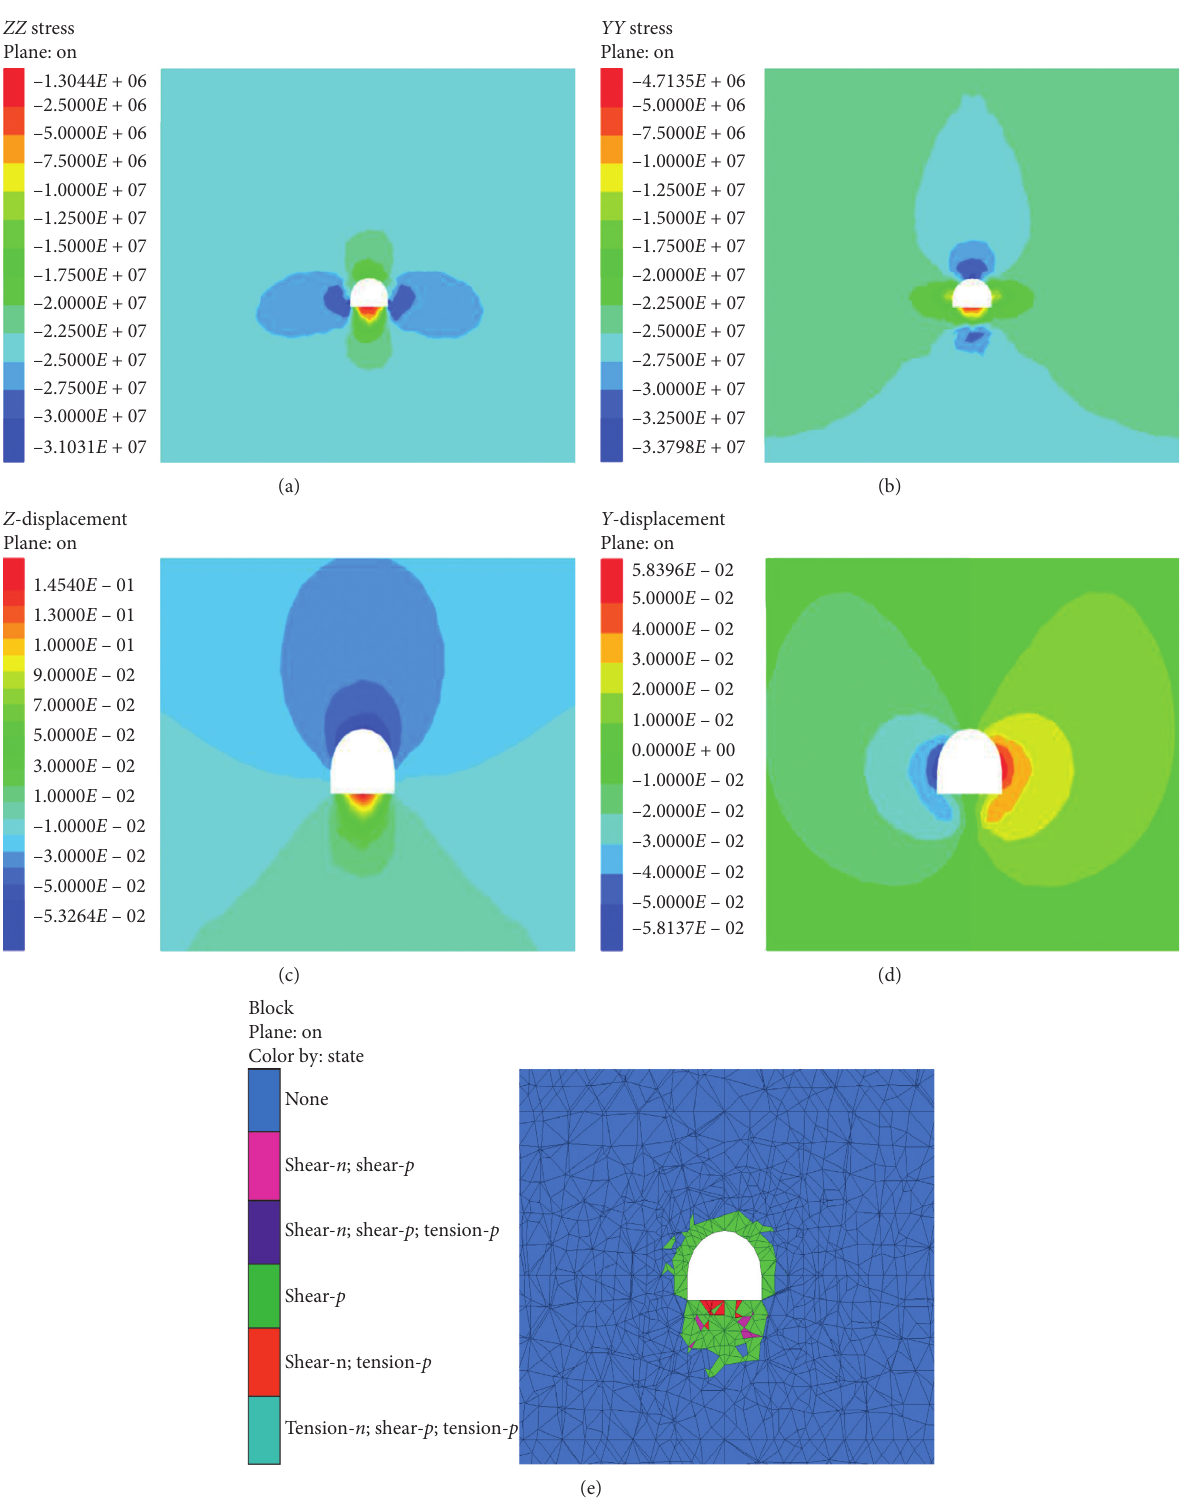
Figure 16: Numerical simulation results of constant-resistance rigid and flexible coupling support: (a) horizontal stress, (b) vertical stress (unit: Pa); (c) Z -displacement, (d) Y -displacement (unit: m), and (e) plastic